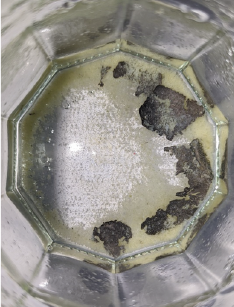
Figure 3. Crystals (white) and corroded Al foil (grey) obtained upon drying of the suspension resulting from the CO